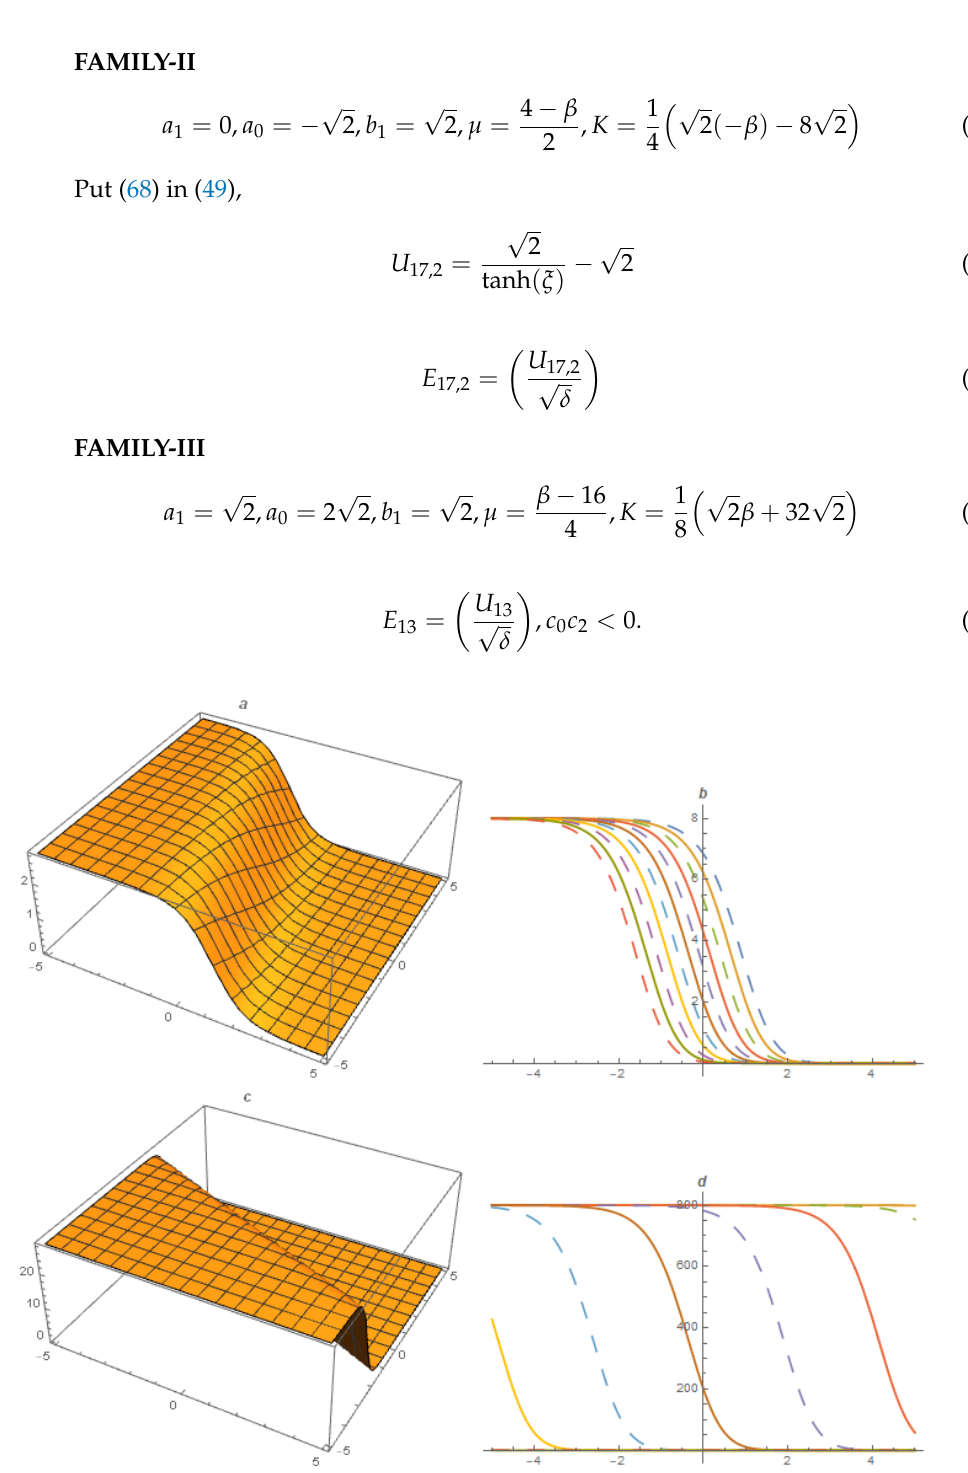
Figure 4. Solutions of U 17,1 ( a , b ) and E 17,1 ( c , d ) with α = 1, β = 3.5 and α = 1, β = − 0.5, δ = − 0.01,